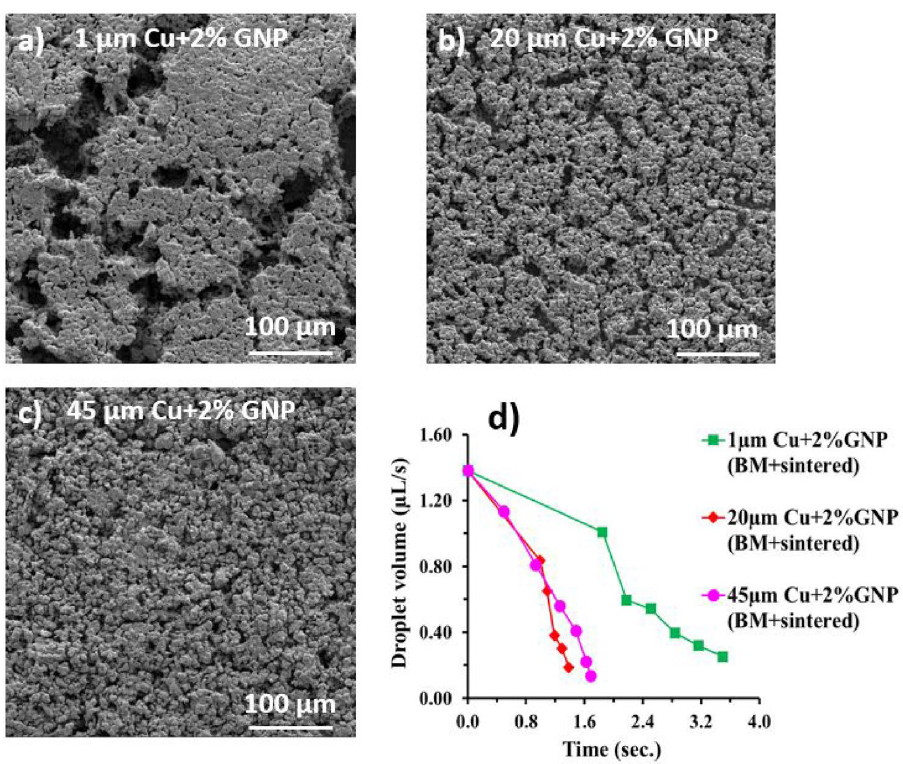
Figure 8. Scanning electron microscope (SEM) images at 500 × magnification of GNP draped Cu coatings ( a ) ball milled and sintered (BM + sintered) 1 µm Cu-2% GNP, ( b ) BM + sintered 20 µm Cu-2% GNP, ( c ) BM + sintered 45 µm Cu-2% GNP, ( d ) comparison of change in water droplet volume over